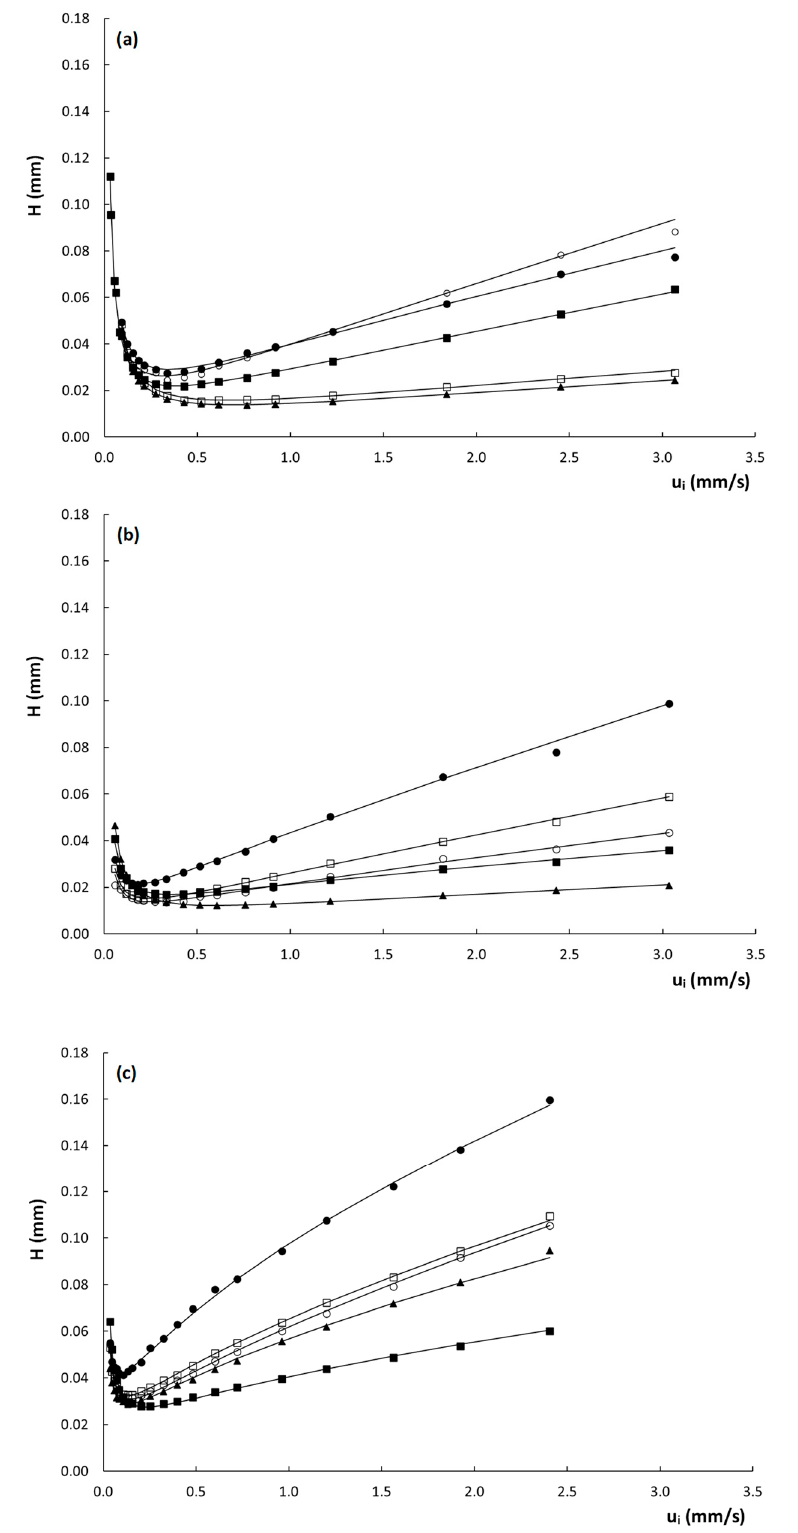
Figure 3. Plate height curves of H versus u i obtained on the ( a ) poly(SPE-co-EDMA) monolithic column, ( b ) poly(SPE-co-MBA) monolithic column and ( c ) ZIC-pHILIC column. k” =1.9–2.2 ( ), k” = 2.9–3.7 ( ), k” = 4.7–6.4 ( ), k” = 6.4–7.3 ( ), k” = 9.7–10.5 ( ). Mobile-phase conditions are given in Table S1.